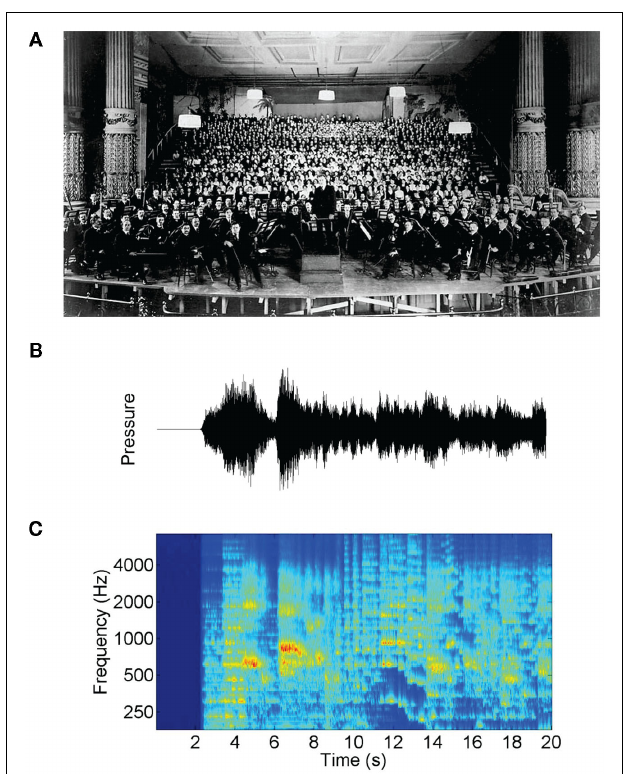
FIGURE 3 |The problem faced by auditory scene analysis. (A) Music creates acoustic scenes with a large number of potential sound sources, as illustrated by this picture taken before the American premiere of Mahler’s eighth symphony – dubbed the “Symphony of aThousand.” Image source: Wikipedia . (B) The acoustic waveform of the first few seconds of Mahler’s eighth symphony (see also Sound Example S1 in Supplementary Material). At any moment in time, the information available to the auditory system is the pressure value at the ear.This value may be reflecting vibrations from an unknown number of physical objects.The challenge of auditory scene analysis is to infer the most likely distal causes that account for the proximal pressure values. (C) Cochleogram of the waveform in (B) .The picture was obtained by passing the acoustic waveform through a model simulating the early stages of auditory processing (Shamma, 1985).The acoustic information is now spread over a two-dimensional time–frequency plane, as would be the case in the tonotopic channels of, e.g., the auditory nerve. The challenge is now at least twofold: to group all the activity belonging to one source and only to that source, even though it may be spread over many tonotopic channels; to bind over time the activity produced by a given source over time. In spite of the problem of being ill-posed, human and other animals are remarkably able at solving it and we are able to follow, e.g., a single speaker in a noisy environment. However, in the case of music, scene analysis usually fails: we cannot hear out each and every singer of the choir, even though they are distinct sound sources.This is precisely one of the points of the paper: how composers steer the inherent ambiguity of auditory scene analysis to achieve “illusory” musical